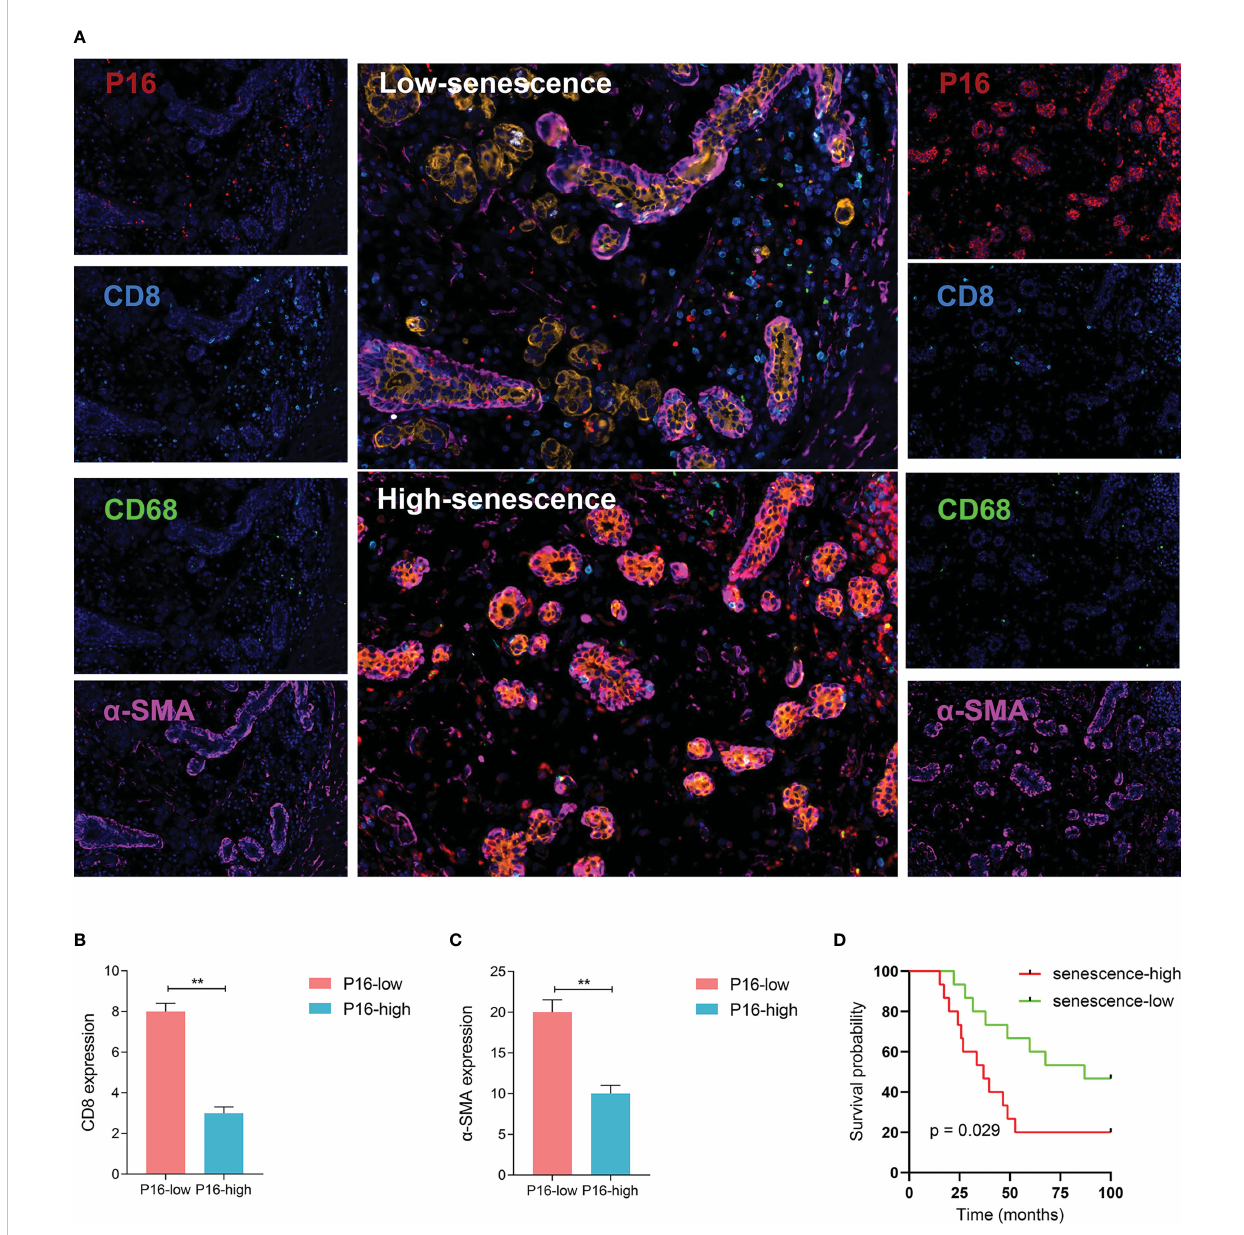
FIGURE 4 Visualized validation of the biological and clinical prognostic effects of senescence. (A) Representative multiplex immunohistochemistry (mIHC) images of patient samples with low-senescence (top panel) and high-senescence (bottom panel), and each color panel on the side. Markers were visualized by colors, with P16 in red, CD8 in turquoise, CD68 in green, a-SMA in pink, KI-67 in white and Pan-CK in orange (single color panels for a- SMA and KI-67 in supplementary), and DAPI counterstained. (B, C) Comparison of immune and stromal content from mIHC images between the high- and low-senescence groups, (B) de fi ning immune status stromal status from the fl uorescent intensity of CD8 in tumor region (annotated based on Pan-CK expression), and (C) similarily for stromal status and a-SMA fl uorescence. (D) P16-based strati fi cation of patients into senescence- high and senescence-low groups and comparison of overall survival by Kaplan-Meier curve. **p <